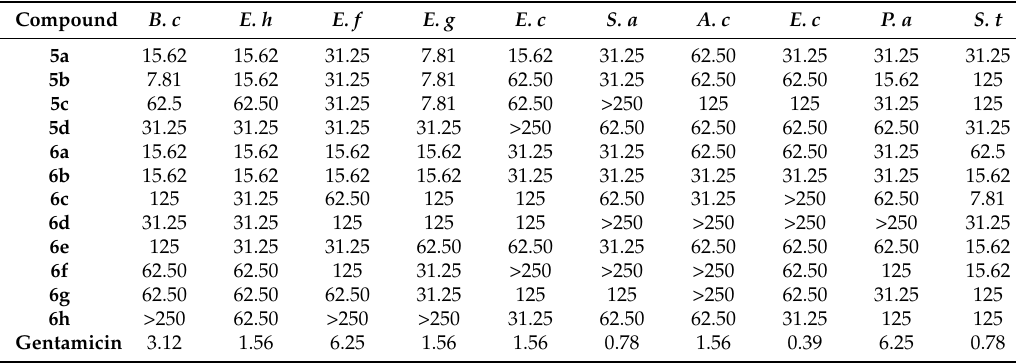
Table 2. Minimum inhibitory concentration (MIC, µ g/mL) of 5a – d and 6a – h against